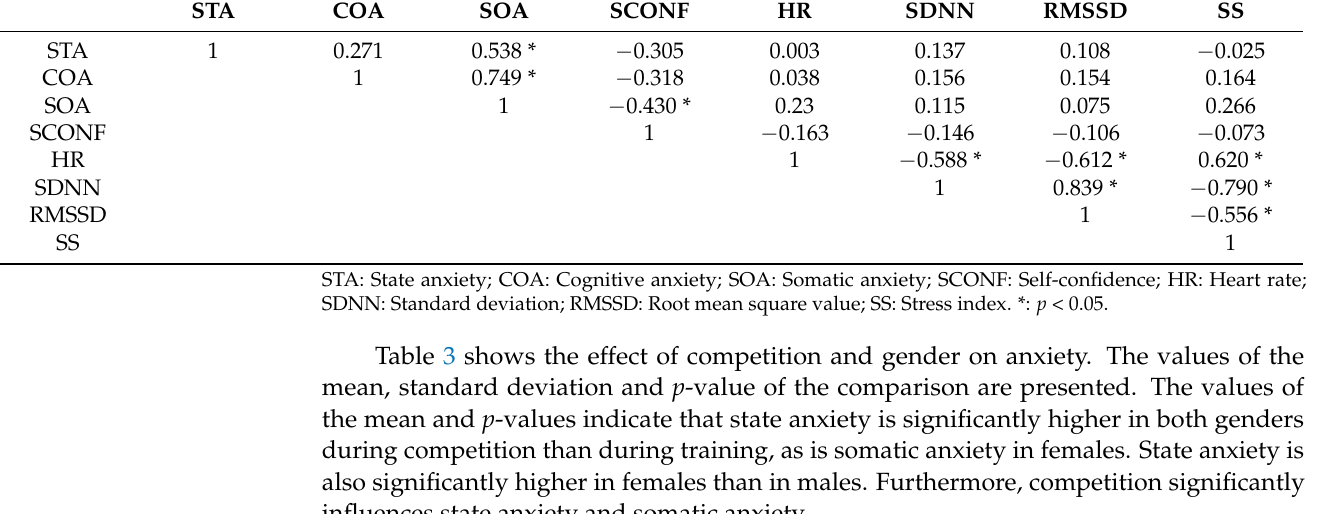
STA: State anxiety; COA: Cognitive anxiety; SOA: Somatic anxiety; SCONF: Self-confidence; HR: Heart rate; SDNN: Standard deviation; RMSSD: Root mean square value; SS: Stress index. *: p < 0.05.